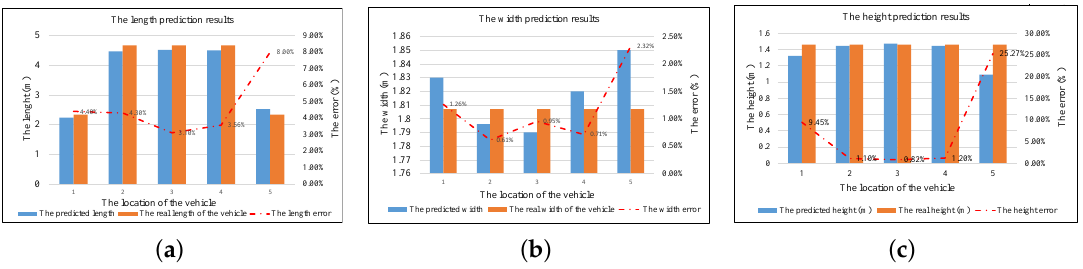
Figure 12. The estimation of the 3D information. ( a ) The length prediction results of the vehicle. ( b ) The width prediction results of the vehicle. ( c ) The height prediction results of the vehicle.